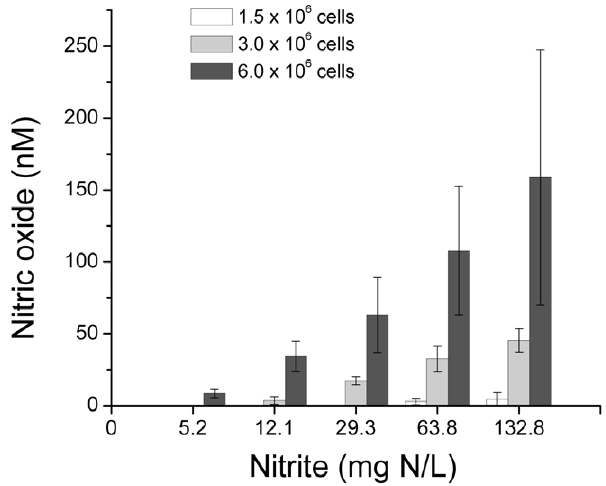
Figure 2. NO 2 2 -dependent nitric oxide production at increas- ing cell densities. Each bar represents the mean 6 SD of 2–3 experiments with different batches of cells.